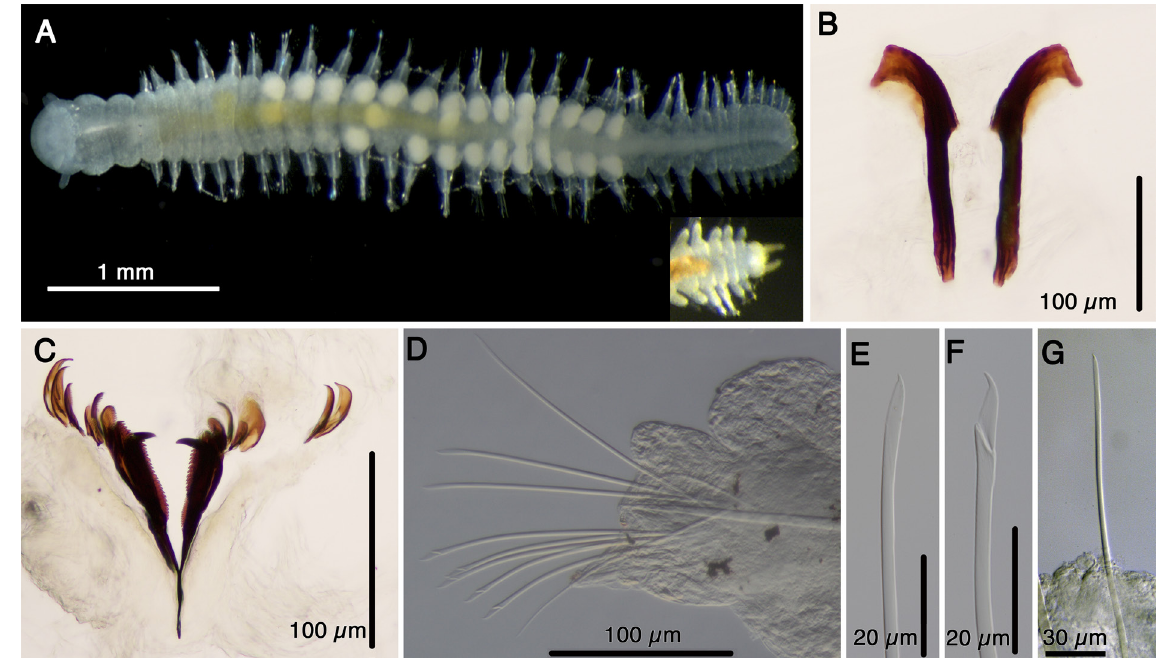
Fig. 5. Ophryotrocha kailae sp. nov. A . Whole body of living holotype (SIO-BIC A14100); inset shows the posterior end of paratype (SIO-BIC A14099) with pygidial cirri. B . Mandibles of paratype (SIO-BIC A14099). C . Maxillae of paratype (SIO-BIC A14099). D . Parapodium of paratype (SIO-BIC A14102). E . Simple supra-acicular chaetae of paratype (SIO-BIC A14102). F . Compound sub-acicular chaetae of paratype (SIO-BIC A14102). G. Simple sub-acicular chaeta of paratype (SIO-BIC